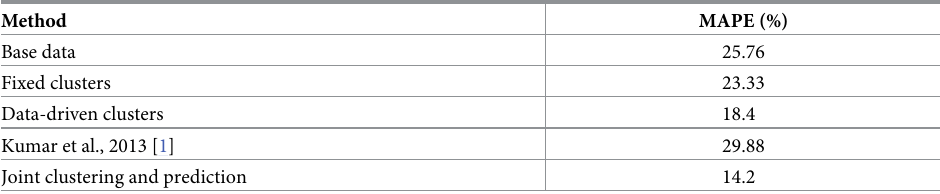
Table 8. MAPE values across different prediction